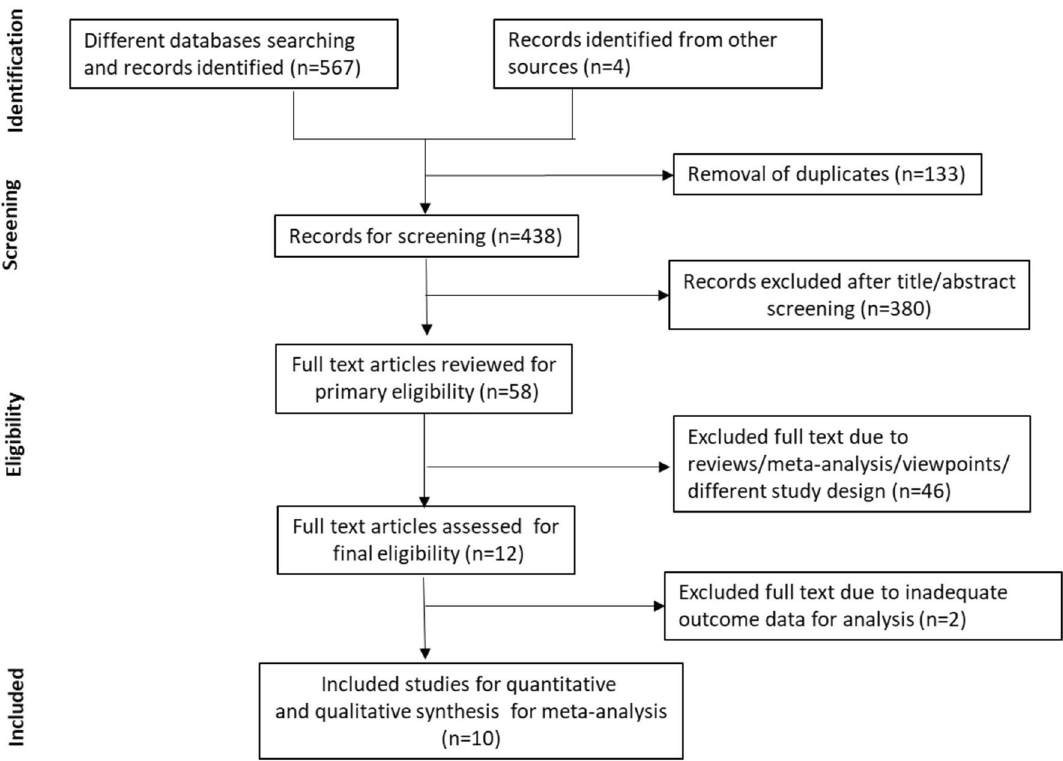
Figure 1. PRISMA flowchart showing the selection of studies for